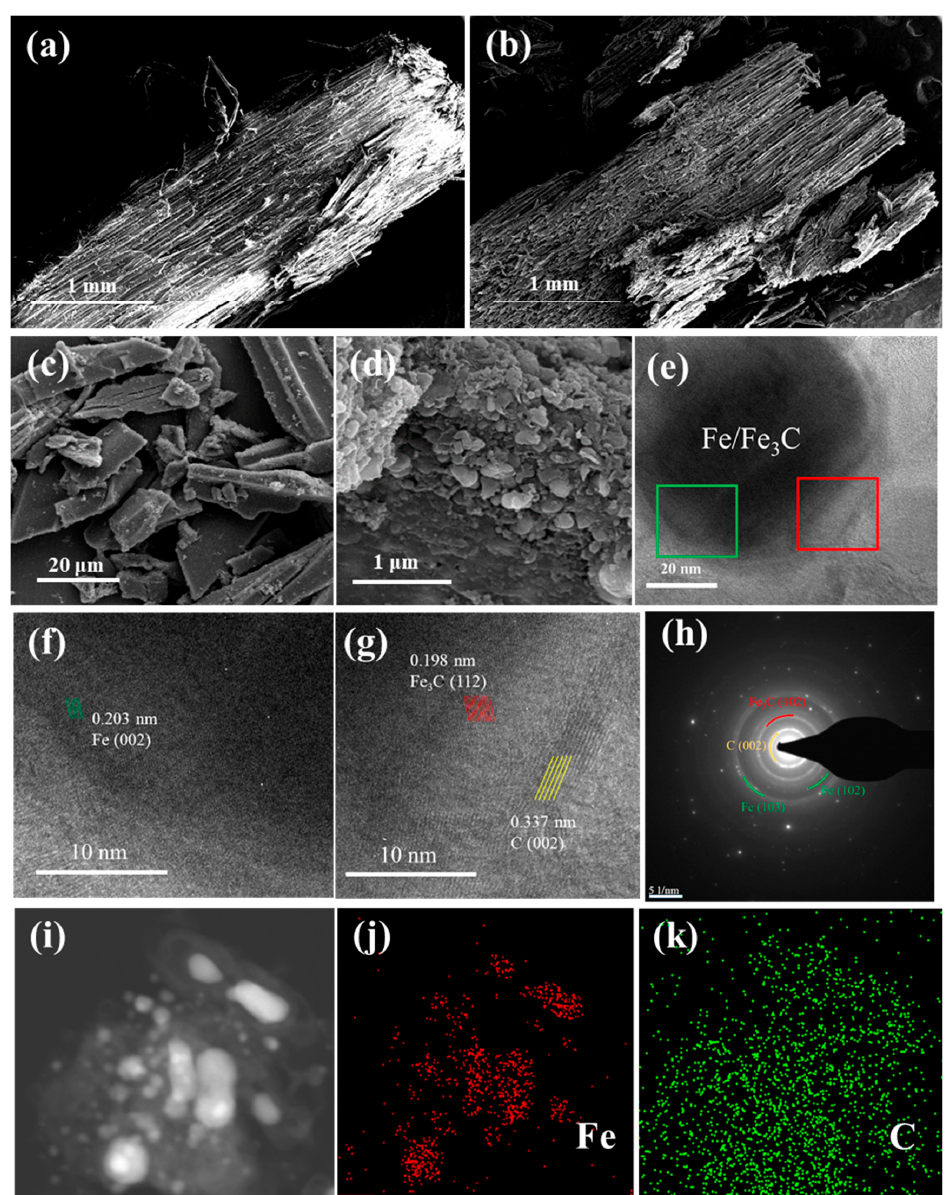
Figure 2. FE-SEM images of ( a ) raw sawdust, ( b ) the mixture of sawdust@Fe(NO3) 3 , ( c – d ) Fe/Fe 3 C@GC composite, ( e – g ) TEM image of Fe/Fe 3 C@GC composite, ( h ) selected area electron diffraction (SAED) composite, ( e – g ) TEM image of Fe / Fe 3 C@GC composite, ( h ) selected area electron di ff raction (SAED) pattern of Fe / Fe 3 C@GC composite, and ( i – k ) EDS mapping of Fe / Fe 3 C@GC